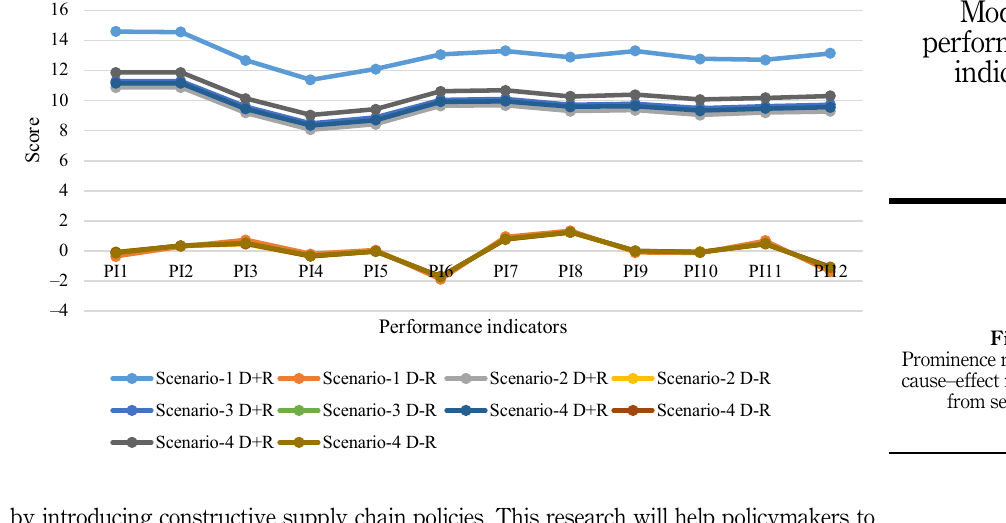
Figure 7. Prominence rank